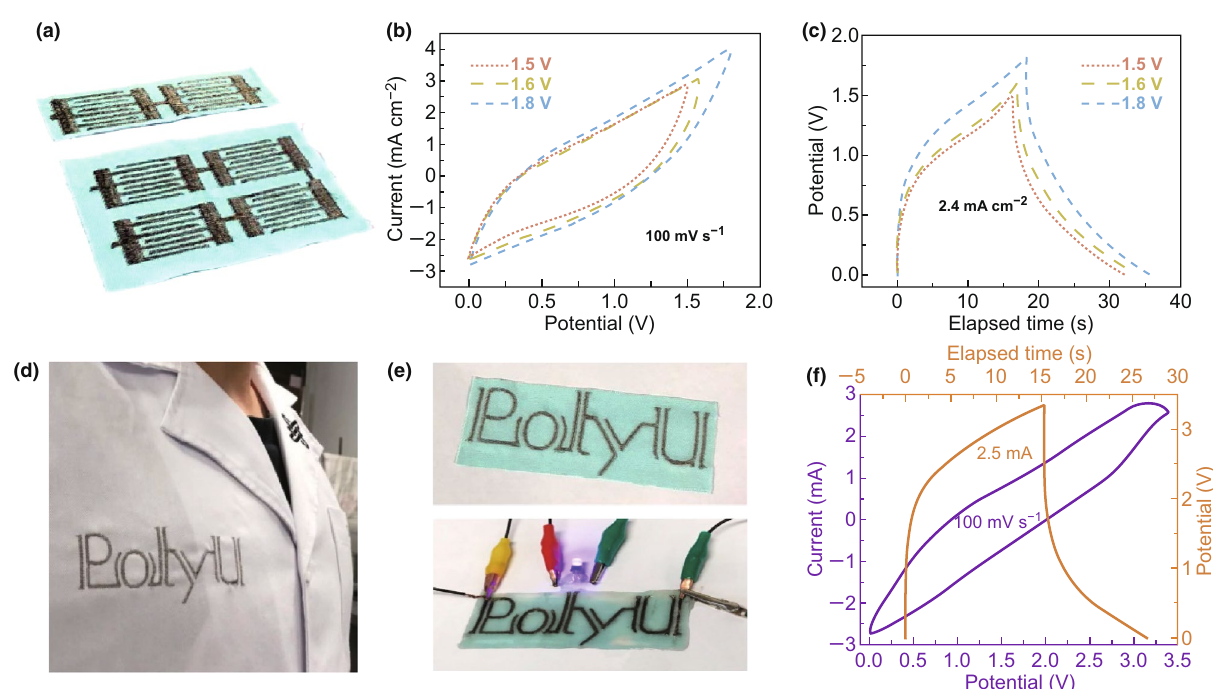
Fig. 6 a Real photographs of two and four embroidery SCs connected in series. b , c CV and GCD curves of two SCs connected in series at a voltage scanning rate of 100 mV s −1 and current density of 2.4 mA cm −2 . d Display of embroidering the “PolyU” monogrammed SC on the laboratory gown. e Electrochemical measurement on the “PolyU” SC. f CV and GCD curve of the “PolyU”